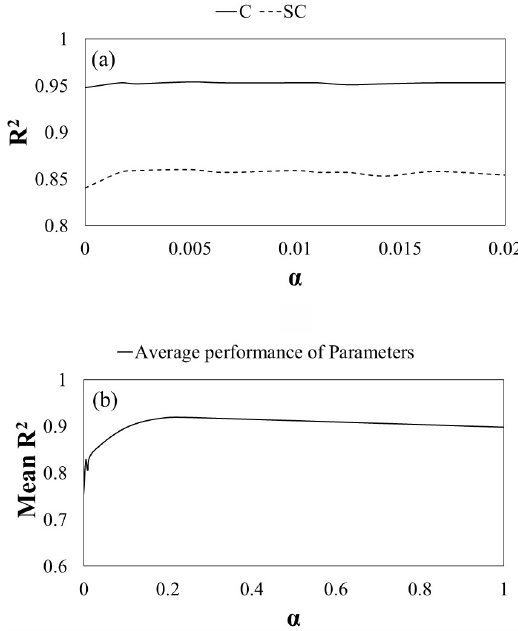
Figure 18. Correlation efficiency results of SSC-DP using different weights of parameter continuity for synthetic experiments with (a) the TMWB model and (b) the Xinanjiang model. The mean R 2 is the average value of the R 2 such that the identification results for parameters with different ranges can be